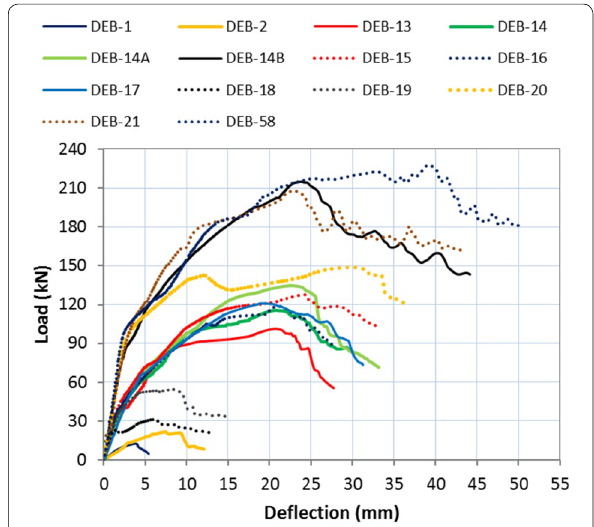
Fig. 16 The load–deflection relationship in the second group.